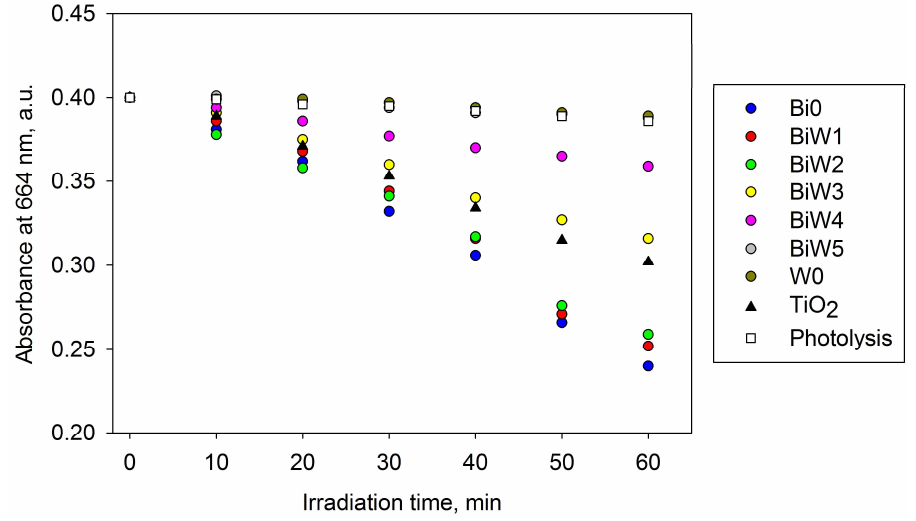
Figure 7. MB absorbance decay rates at 664 nm under fluorescent light irradiation.